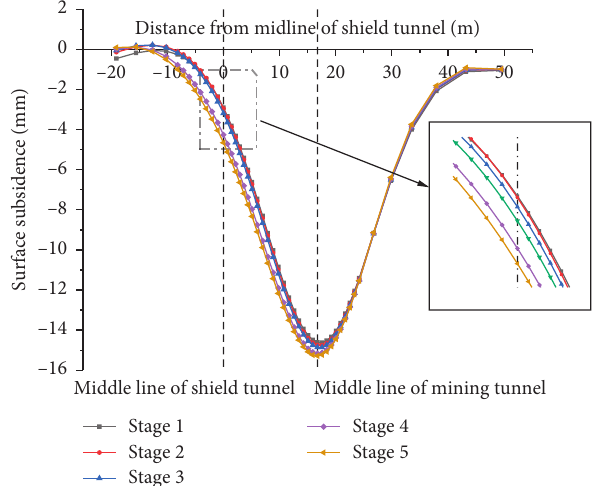
Figure 22: Ground settlement curve after shield